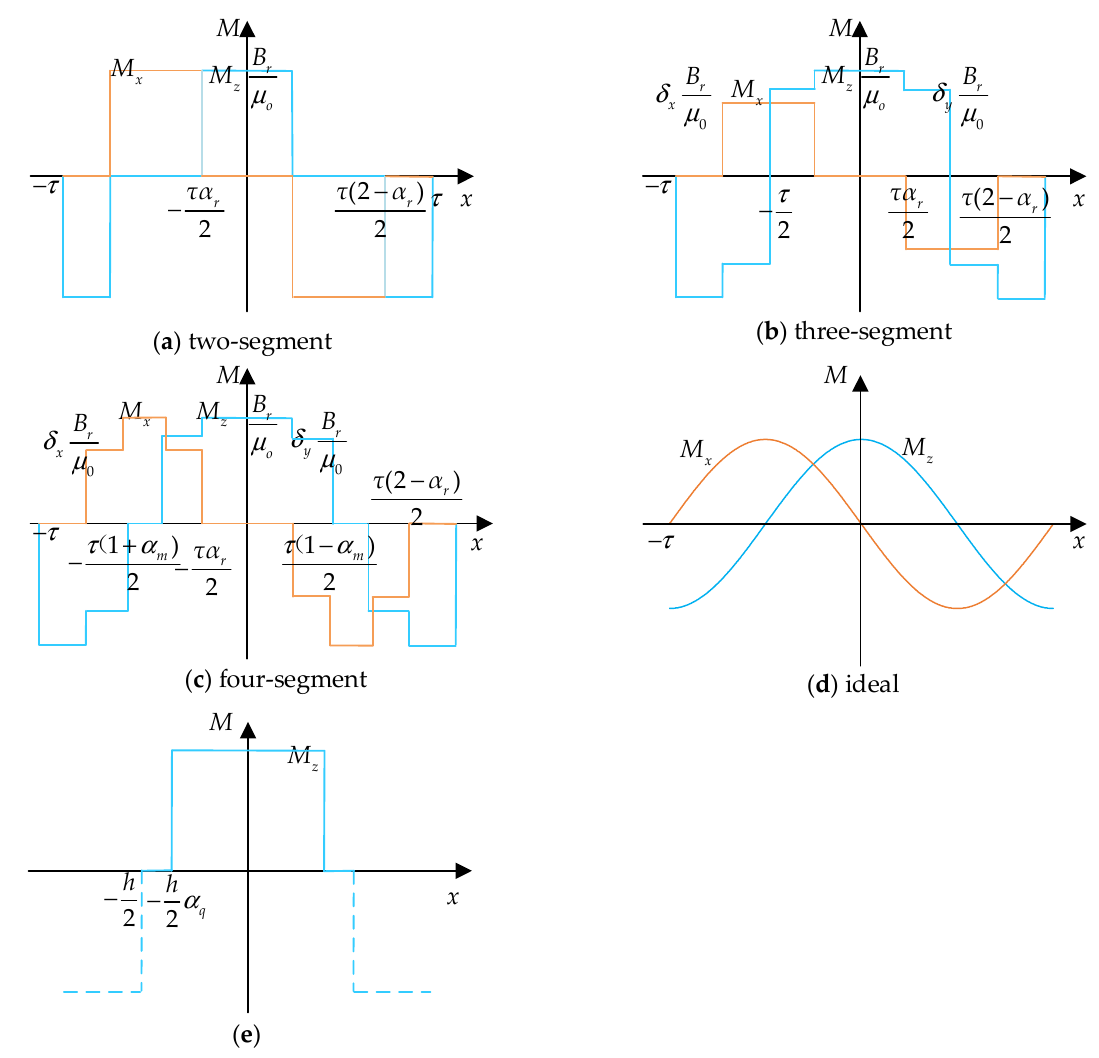
Figure 4. The magnetization components of magnet arrays with different Halbach arrays in ( a – d ) along the x-direction and ( e ) along the z-direction.